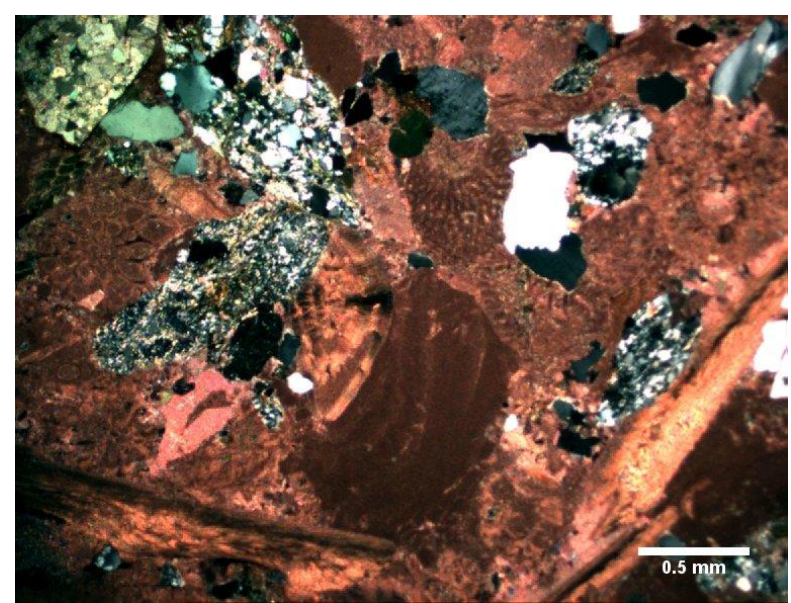
Figure 5. A photomicrograph of the typical Middle Miocene (Badenian) calcarenite from northern Croatia (Breznički Hum locality), stained with alizarin red.